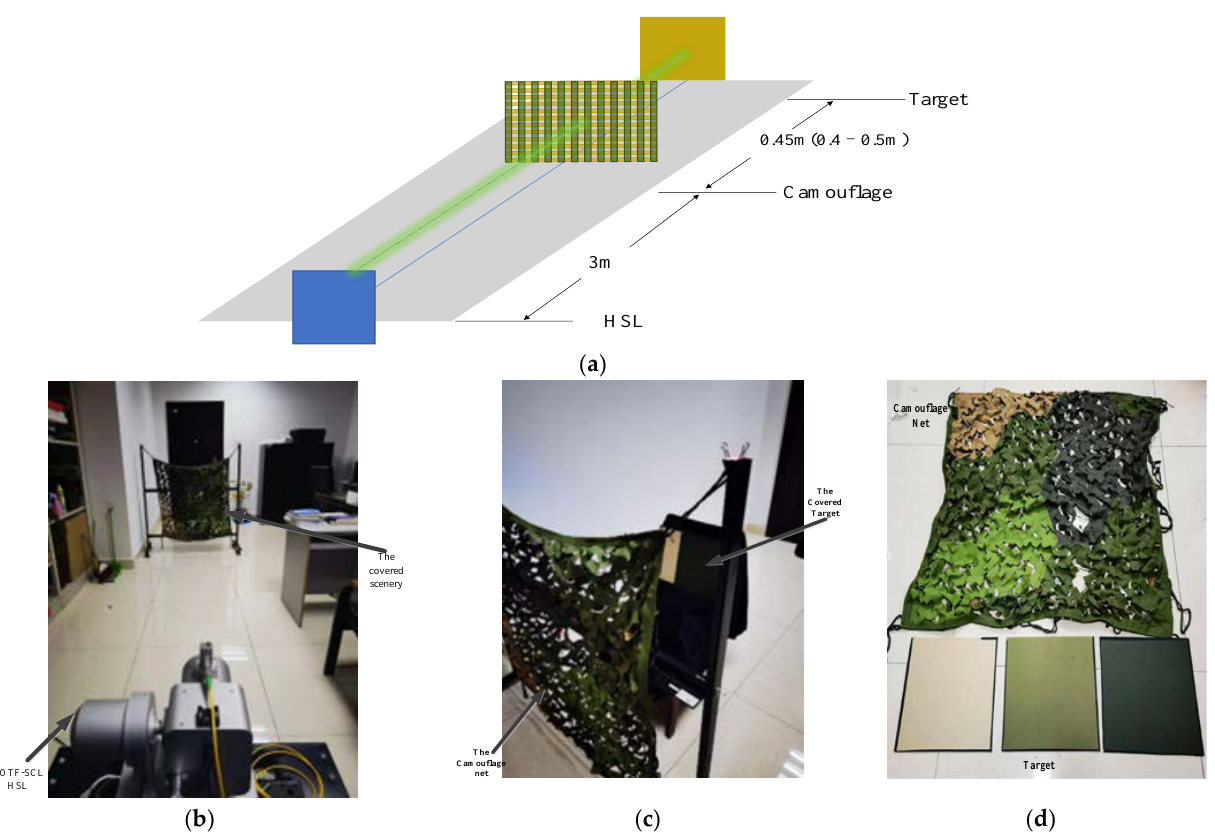
Figure 3. ( a ) Ideal and ( b , c ) experimental scenarios. ( d ) Experimental equipment including camou- flage web and target.